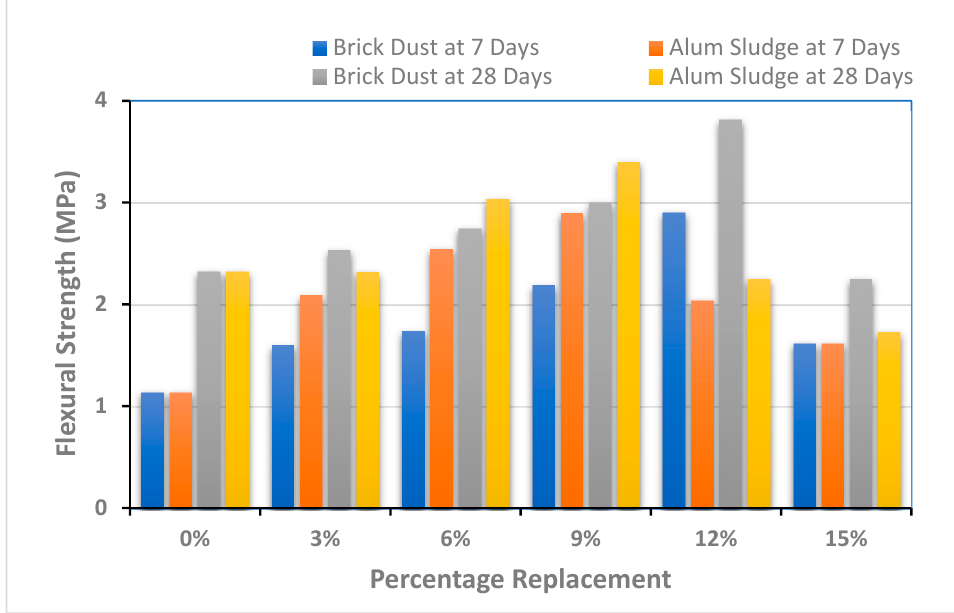
Figure 7. Flexural strength performance of composite material.